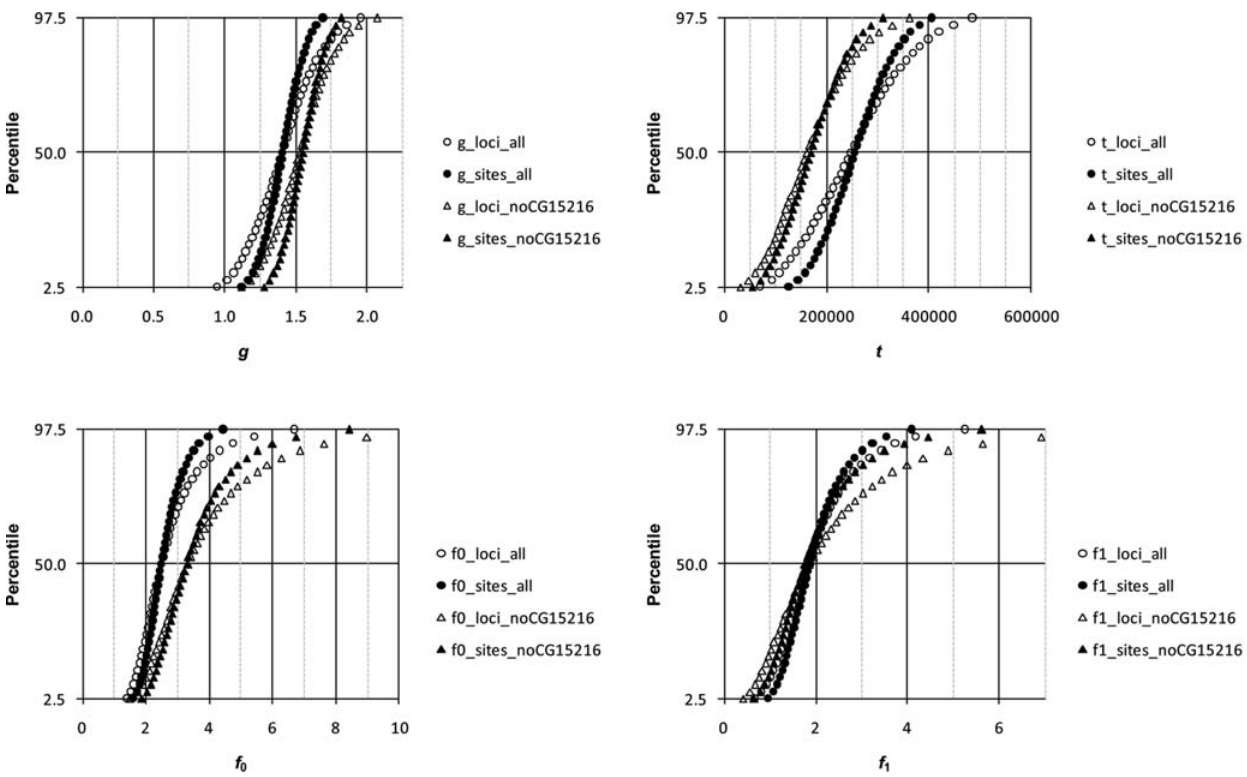
Figure 5. Distribution of parameters estimated from 10,000 bootstrapped data sets using the 4-parameter model for D.simulans and D.sechellia . See Figure 1 for details.